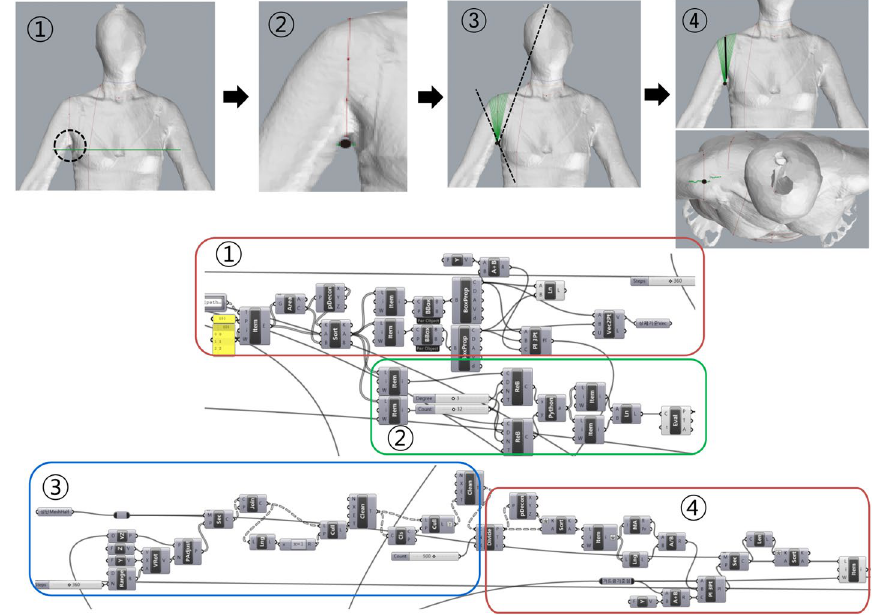
Fig. 5 Armscye line and shoulder point search